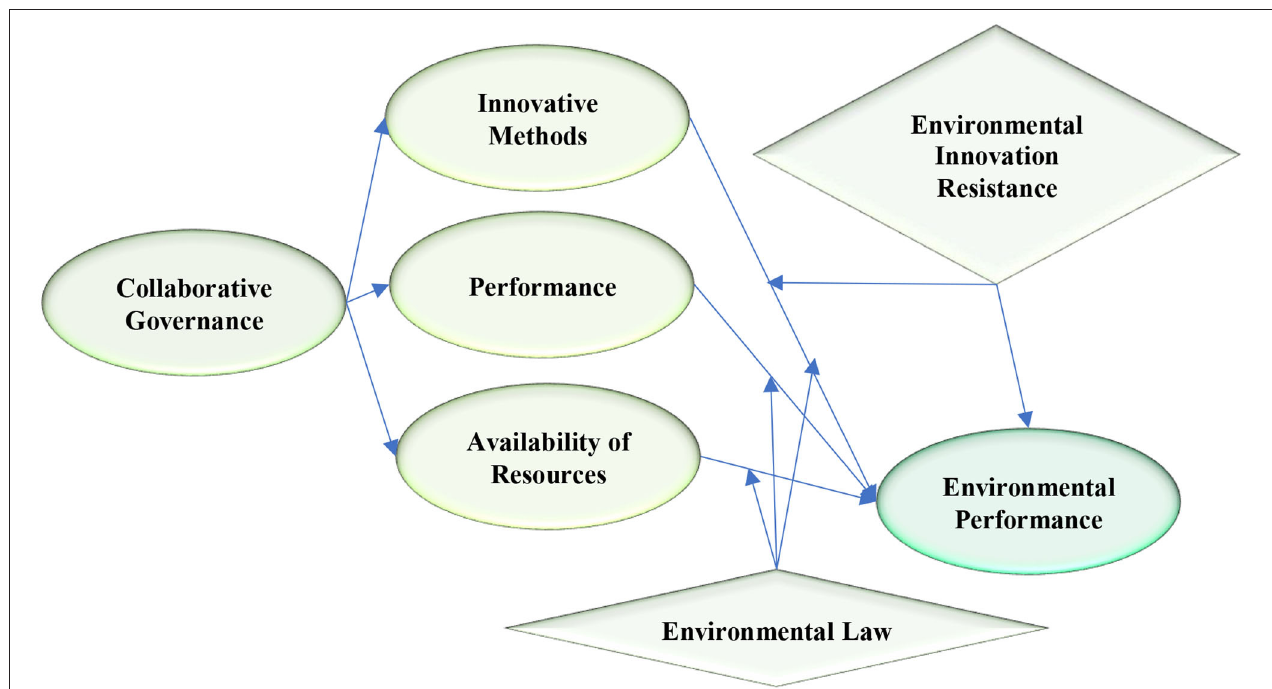
FIGURE 1 | Research